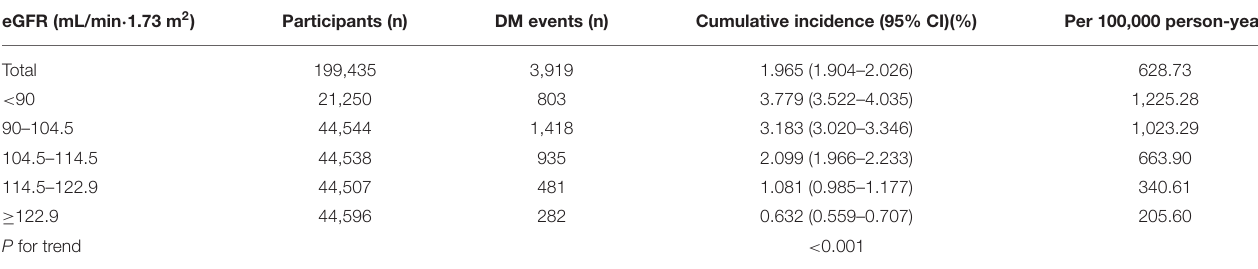
TABLE 2 | Incidence rate of incident diabetes.